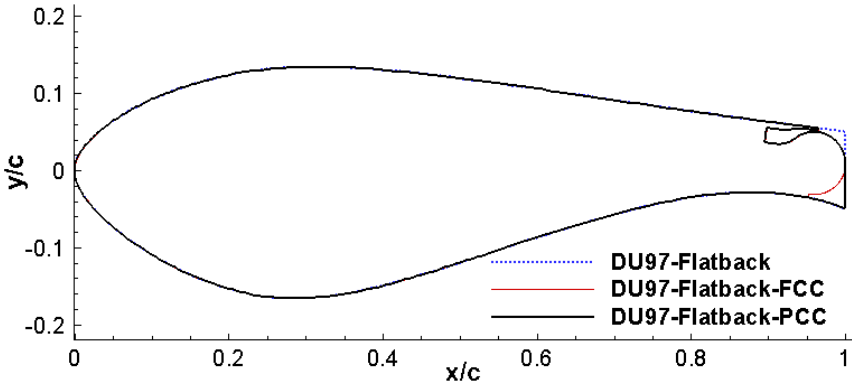
Figure 1. Profiles of the flatback and CC (Circulation Control) airfoils.